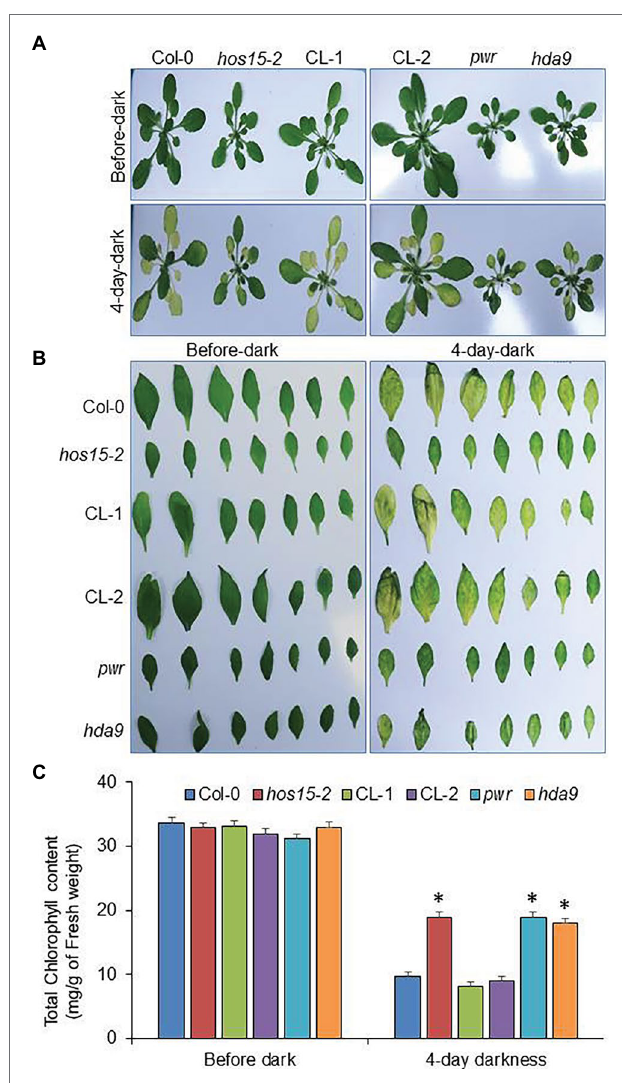
FIGURE 3 | hos15-2 mutant delays yellowing during dark stress. (A) The phenotypic analysis of Col-0 (WT) , hos15-2 , CL-1, CL-2, pwr , and hda9 plants during dark stress. The 4-week-old plants were treated with dark stress for 4 days. (B) Dark-induced phenotype of cauline leaves of Col-0, hos15-2, CL-1, CL-2, pwr , and hda9 during dark stress. The cauline leaves (1st and 2nd leaves) of the above-mentioned genotypes were introduced to dark stress for 4 days at room temperature conditions. The photographs were taken before and after dark stress. Each experiment was repeated three times with similar results. (C) Leaves of the 4-week-old plants of the indicated genotypes (3rd and 4th rosette) were used for measurement of chlorophyll under control condition and in the presence of 4-day dark stress. Error bars show SD. Significant differences were determined via Student’s t -test (significance: * p <